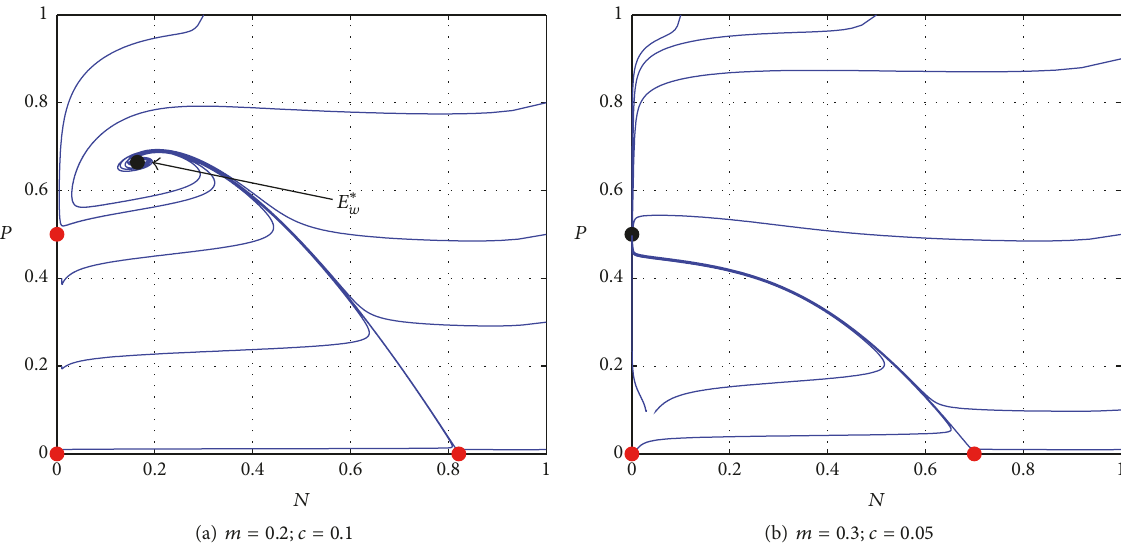
Figure 4: Phase portrait of system (6). The values of parameters are 𝑠 = 0.02, 𝑘 = 0.5,ℎ = 0.3 , 𝜔 = 0.7 , 𝑎 = 1 , 𝑏 = 0.5 , 𝛼 = 0.95 , and Δ𝑡 = 0.1 .